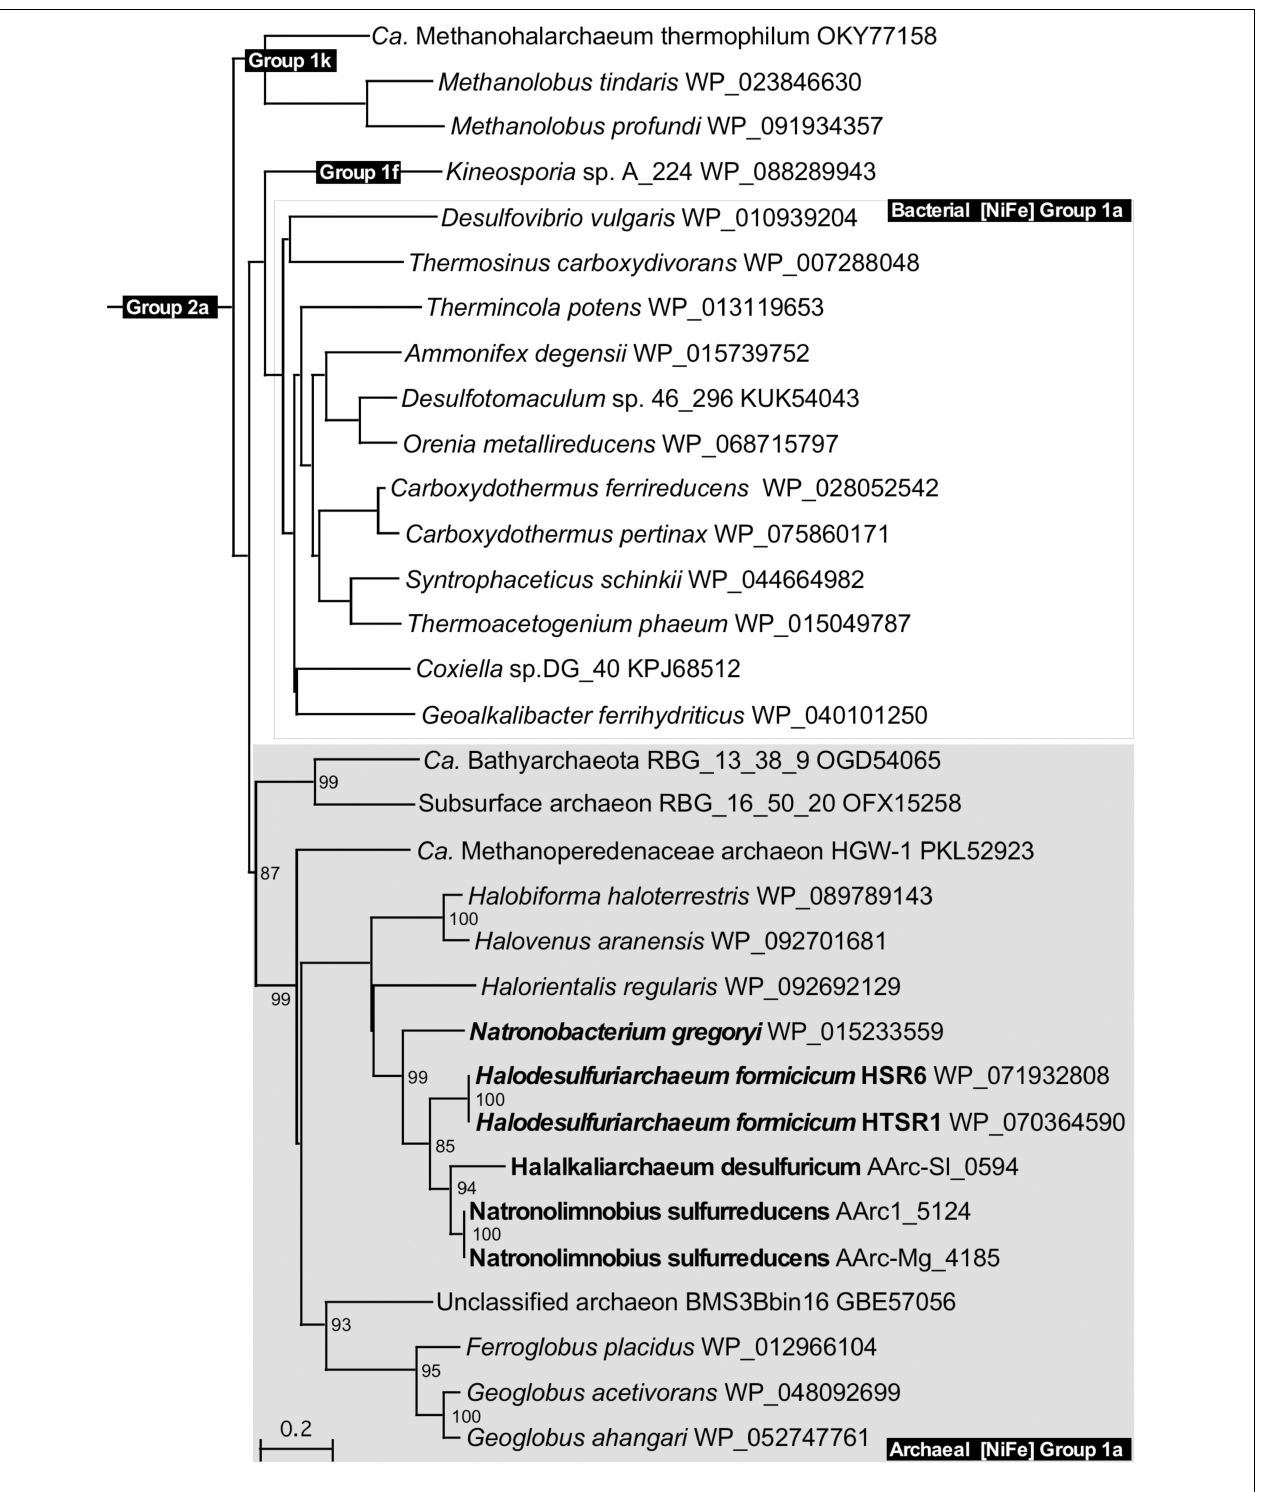
FIGURE 7 | Phylogenetic tree of all haloarchaeal respiratory H 2 -uptake [NiFe]-hydrogenases constructed with full-length HydB subunits. The bootstrap values of more than 75%, supporting topological placement of haloarchaeal HydB subunits, are displayed as percentages close to the corresponding nodes. Members of the class Halobacteria with experimentally confirmed ability for lithotrophic growth with hydrogen are highlighted in bold. [NiFe] Group 2a-hydrogenases of Ca. Syntrophoarchaeum caldarius (GenBank accession no. OFV67551) was used as the out-group. Branch lengths along the horizontal axis reflect the degree of relatedness of the sequences